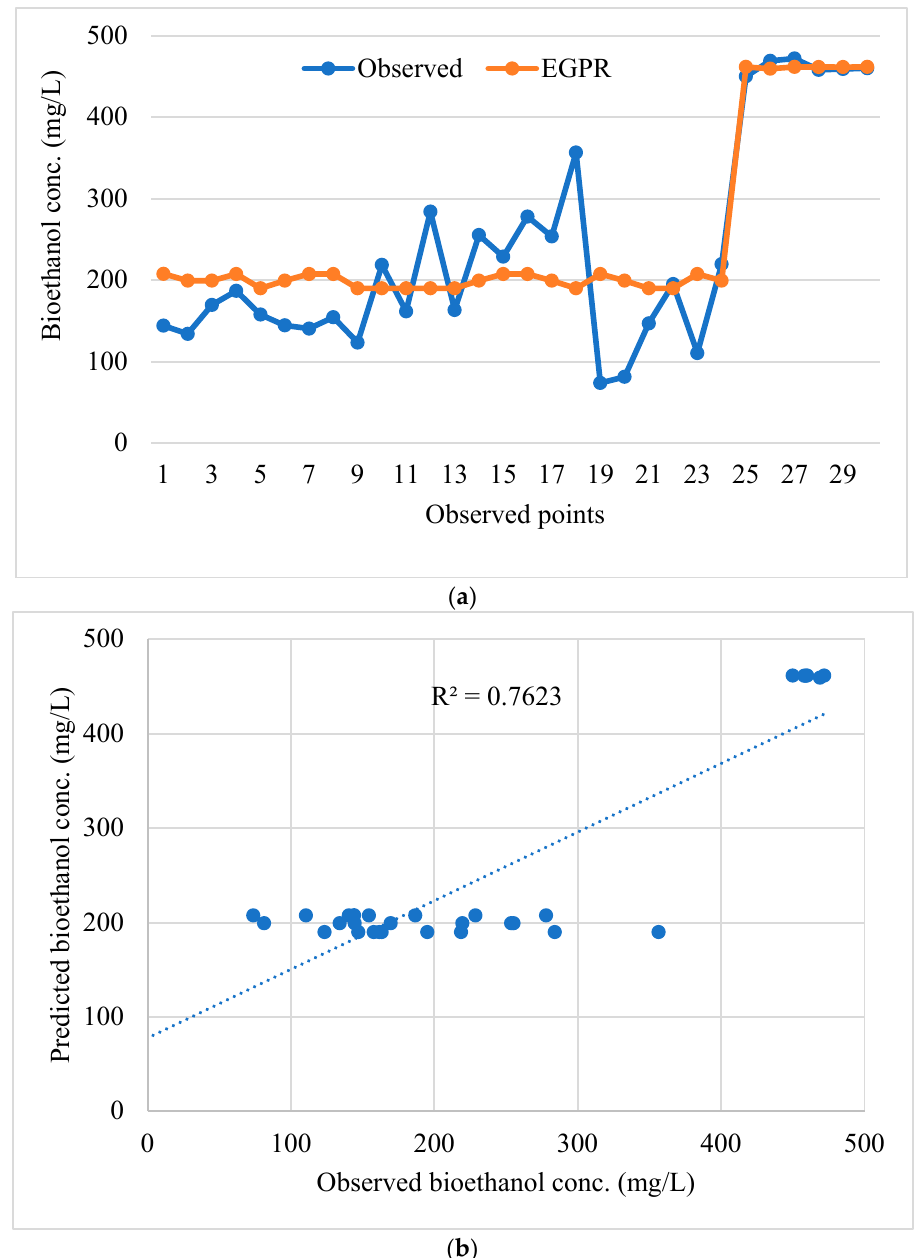
Figure 5. ( a ) Dispersion plots showing the comparison between the actual and the EGPR predicted bioethanol. ( b ) Regression plots showing the observed and EGPR predicted bioethanol.